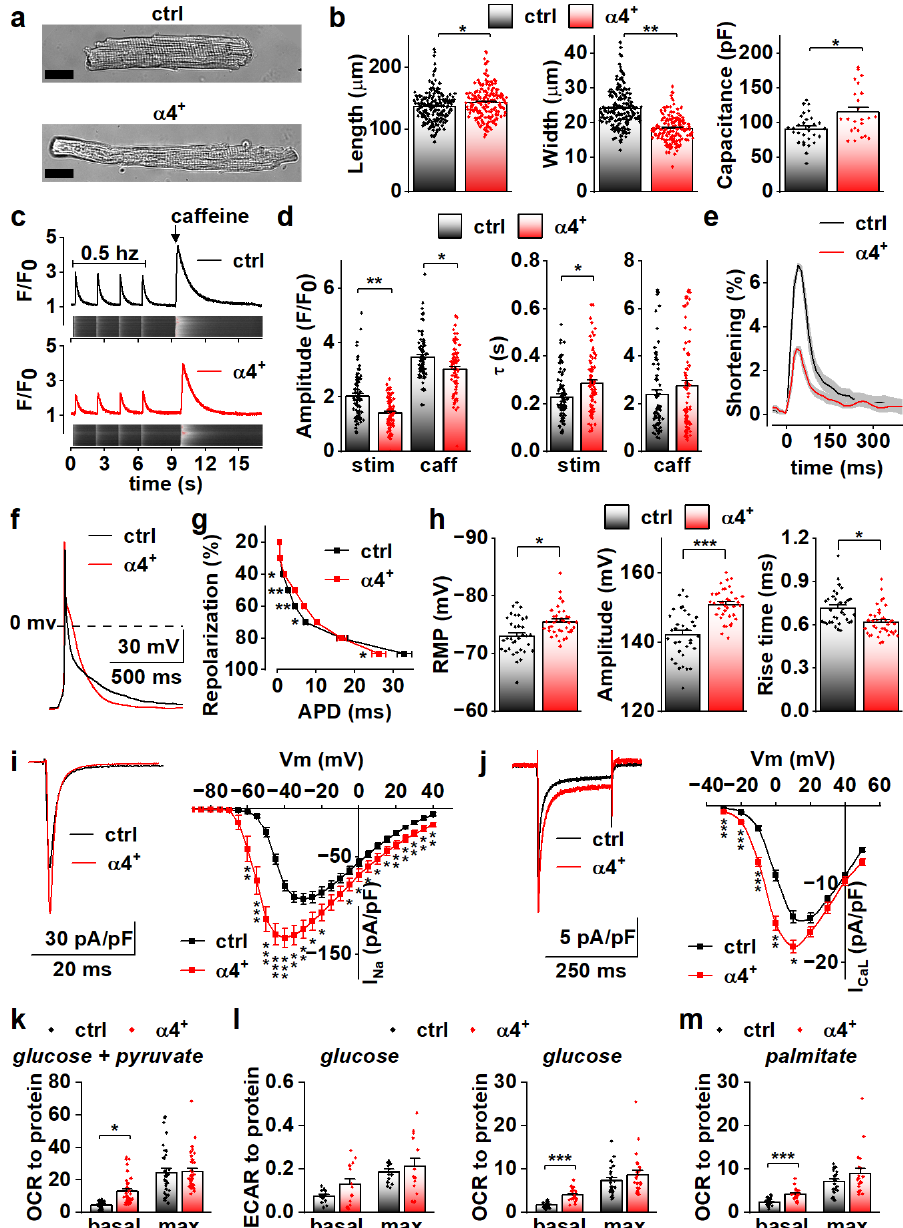
Figure 3. PGC-1 α 4 Overexpression Leads to Distinct Changes in Cardiomyocyte Phenotype. ( a ) Representative light microscopic images from isolated control (ctrl) and Pgc-1 α 4-overexpressing ( α 4 + ) cardiomyocytes. Scale bar 20 µm. ( b ) Length, width (left, middle, n [ctrl] = 2/178 (animals/cells), n [ α 4 + ] = 2/166) and membrane capacitance (right, n [ctrl] = 5/30, n [ α 4 + ] = 3/24) of isolated cardiomy- ocytes. ( c ) Representative calcium transients from Fluo-4 loaded cardiomyocytes. ( d ) Amplitudes (left) and decay times (right) of the stimulation-evoked (stim) and caffeine pulse (caff) calcium tran- sients ( n [ctrl] = 4/77, n [ α 4 + ] = 5/79). ( e ) Averaged shortening of imaged cardiomyocytes caused by stimulation ( n [ctrl] = 37, n [ α 4 + ] = 9, grey area represents SEM). ( f ) Representative action potentials from isolated control and α 4 + cardiomyocytes. ( g ) Action potential duration (APD) plotted against repolarization phase ( n [ctrl] = 4/31, n [ α 4 + ] = 4/35). ( h ) Resting membrane potential (RMP, left), am- plitude (middle) and rise time (right) of the action potential ( n [ctrl] = 4/34, n [ α 4 + ] = 4/38). ( i ) Repre- sentative traces (left) and current–voltage curves (right, n [ctrl] = 5/26, n [ α 4 + ] = 3/23) of sodium cur- rent. ( j ) Representative traces (left) and current–voltage curves (right, n [ctrl] = 3/19, n [ α 4 + ] = 3/14) of L-type calcium current. ( k ) Basal and maximal (max, induced with FCCP) oxygen consumption rates (OCR) in isolated cardiomyocytes supplemented with glucose and pyruvate ( n [ctrl] = 5/33 (an- imals/seahorse wells), n [ α 4 + ] = 5/38). ( l ) Basal and maximal extracellular acidification rates (ECAR,